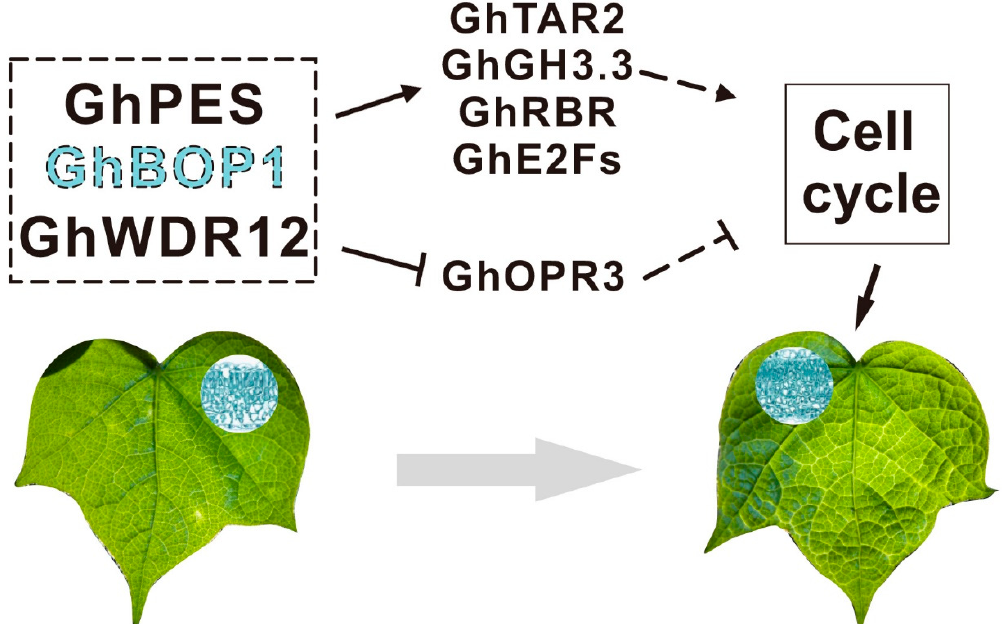
Figure 6. Pathway diagram of GhBOP1 associated with cell cycle progression. The dotted box represents the PeBoW protein complex, and the dotted line GhBOP1 represents gene silencing.